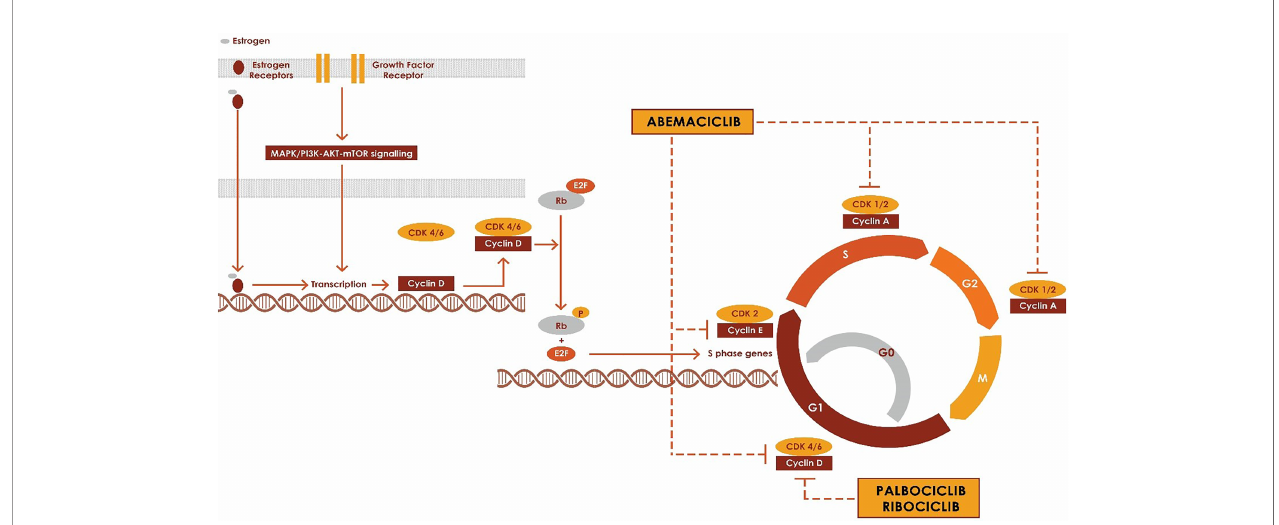
FIGURE 1 | Mechanism of action of CDK 4/6